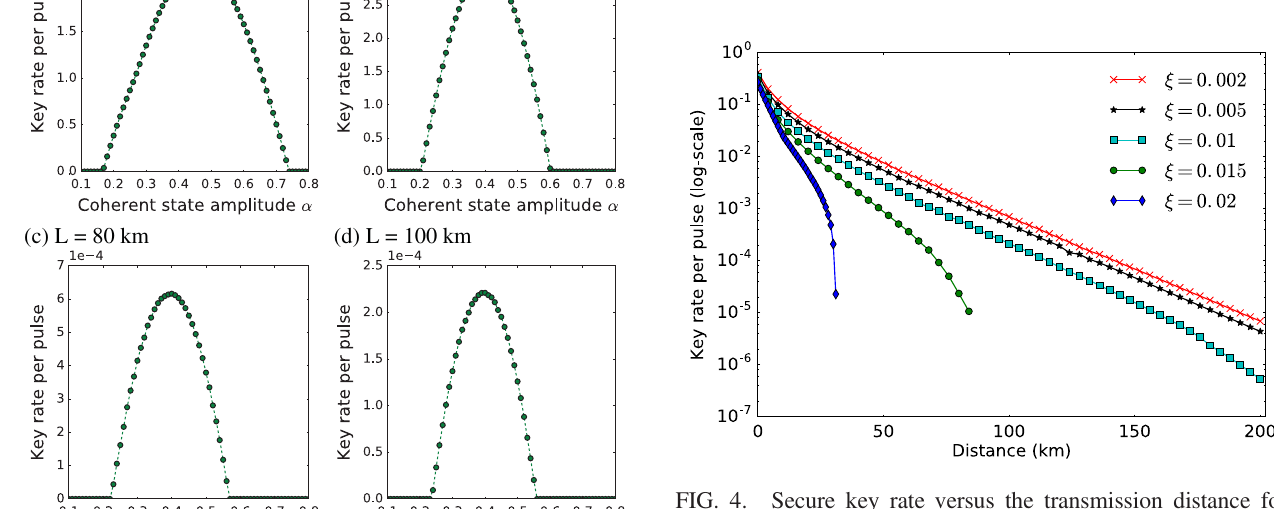
FIG. 4. Secure key rate versus the transmission distance for protocol 1 (with homodyne detection) for different values of the excess noise, from top to bottom, ξ ¼ 0 . 002 , 0.005, 0.01, 0.015, 0.02. The coherent state amplitude α is optimized via a coarse- grained search in the interval [0.35, 0.6], the transmittance is η ¼ 10 − 0 . 02 L for each distance L in kilometers, and the recon- ciliation efficiency is β ¼ 0 . 95 .